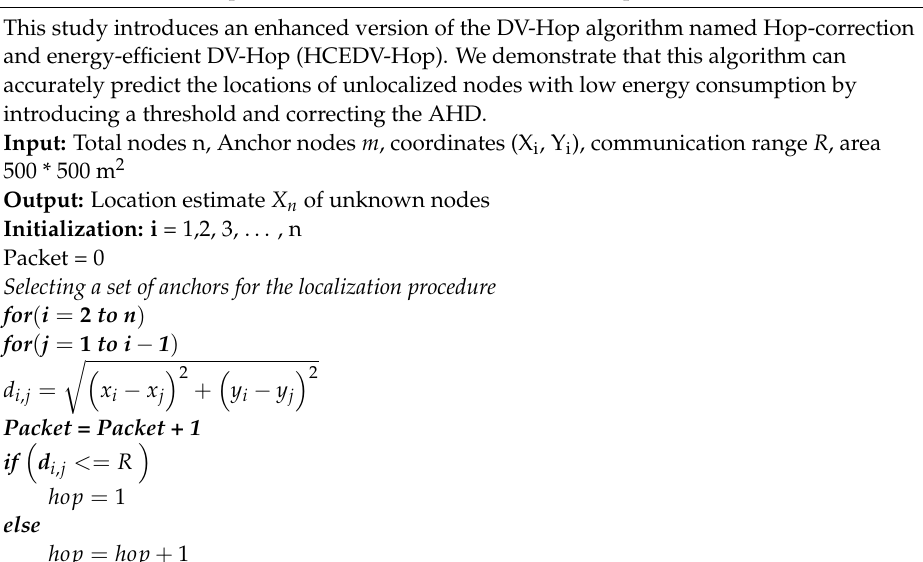
Algorithm 1 HCEDV-Hop WSN Localization with Correction